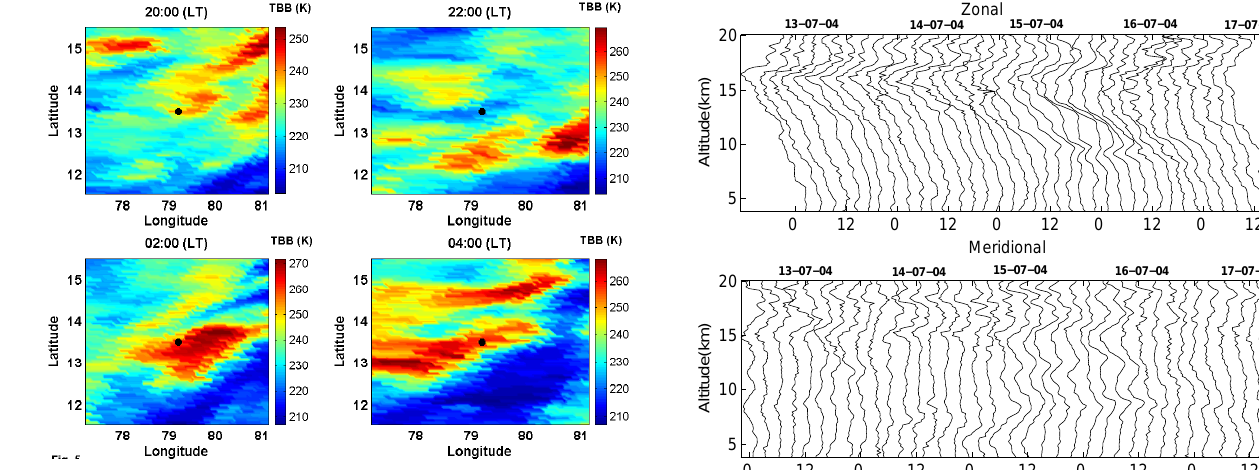
Fig. Fig. 6. Profiles of zonal (a) and meridional (b) winds shifted by 9 and 10m/s, measured by MST radar during 13–17 July 2004 which have been shifted by